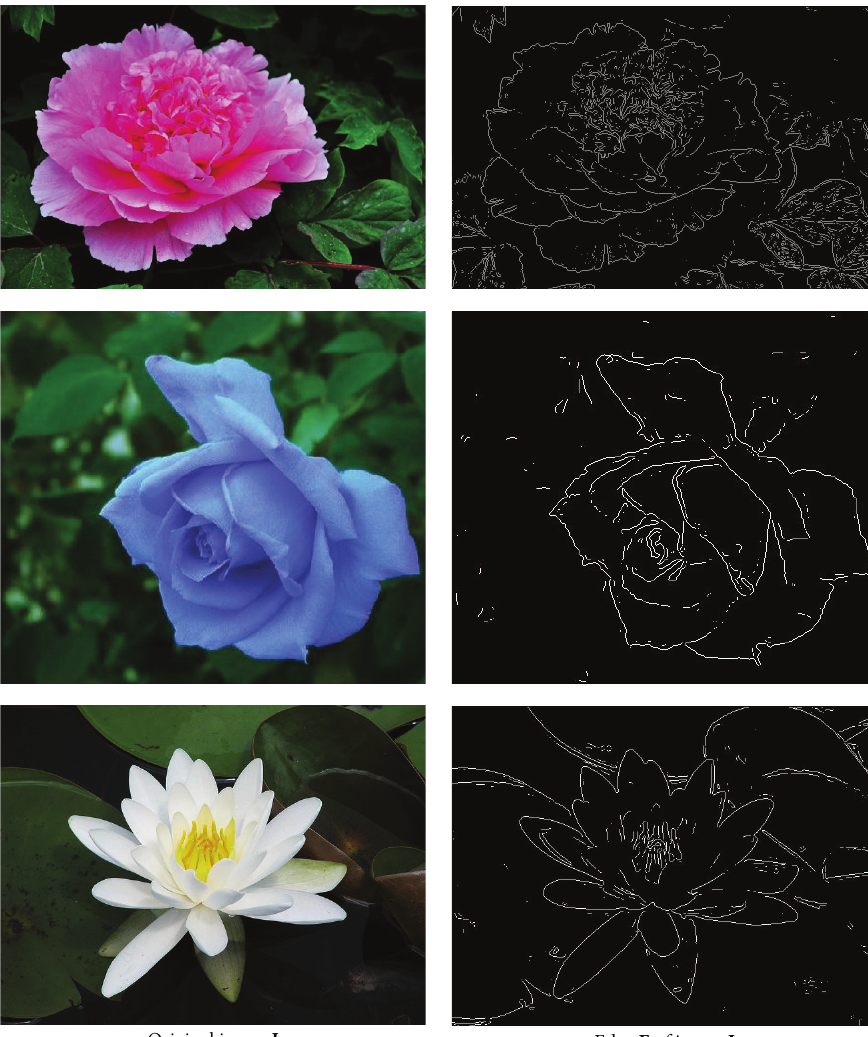
Figure 1: Illustration of relation between image and